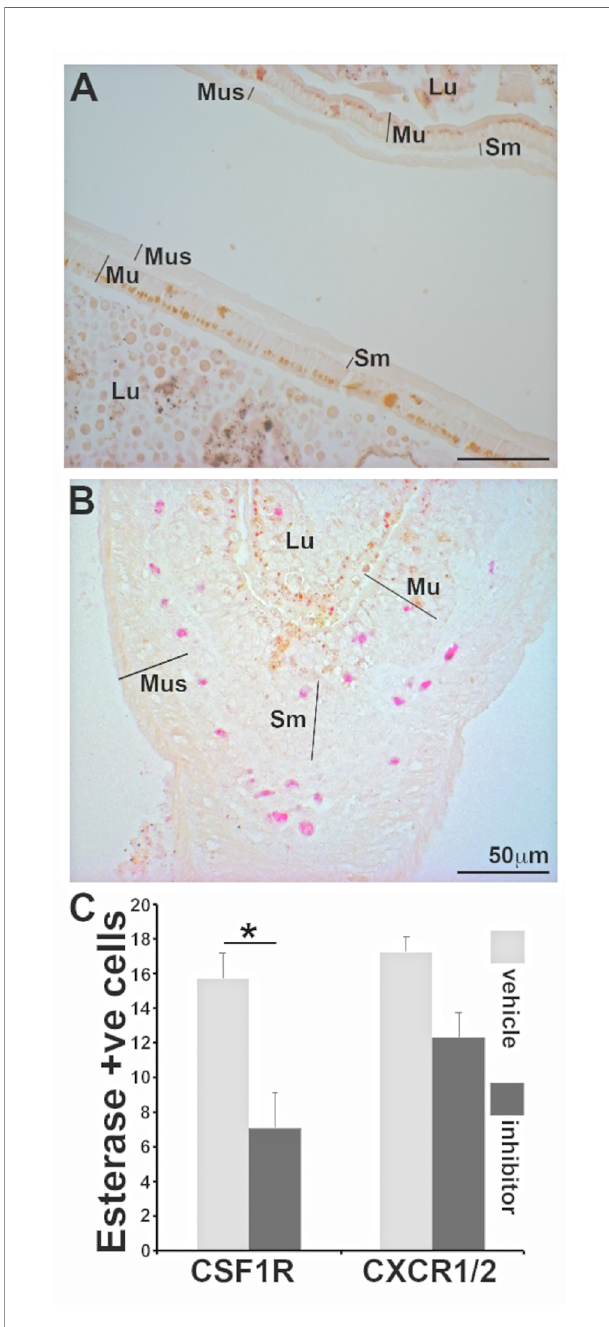
FIGURE 6 | Frog intestines are populated my esterase positive myeloid cells during metamorphosis in a CSF1R-dependent manner. Representative images of intestines from (A) vehicle control (NaOH) and (B) T3 (10 nM fi nal concentration)-treated tadpoles were examined by NASDCl-speci fi c esterase (Leder) stain. Lu: lumen; Mu: mucosal; Sm: sub-mucosal r; Mus: muscularis layers. (C) Means ± SE ( N =6 per treatment group) of speci fi c-esterase positive cells (per fi eld of view) in T3 (10 nM fi nal concentration)-treated tadpoles administered with a vehicle control (DMSO in saline), a CSF1R inhibitor (GW-2580; 100 mg/kg body weight) or a CXCR1/2 inhibitor (reparixin; 50 mg/kg body weight). Asterisks above a line (*) denote statistical differences between the treatment groups denoted by the line, p